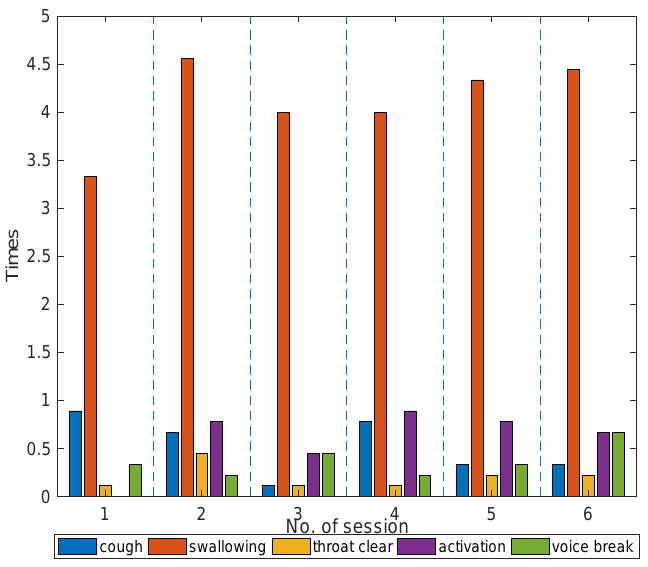
Figure 6. Mean counts of vocal fatigue symptom appearances for all participants during the VLTs in terms of session. The vertical blue dash lines separate different VLT